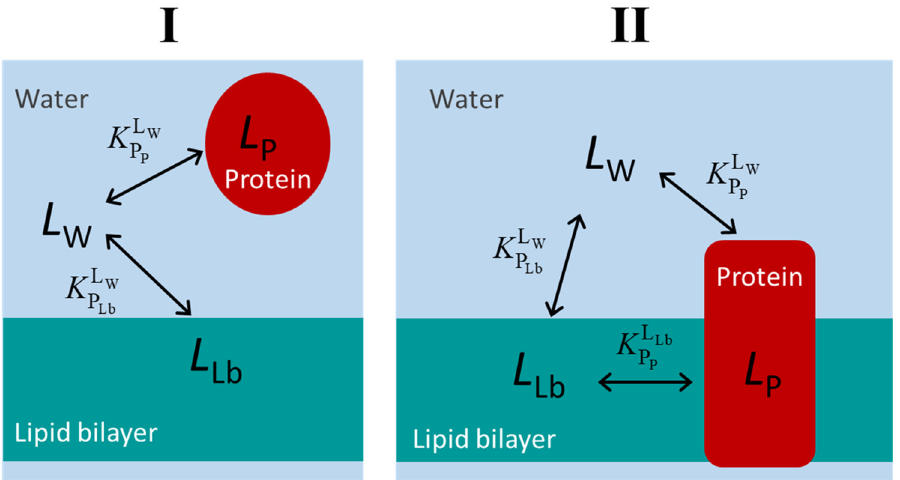
Figure 1. Kinetic schemes for the equilibrium distribution of the ligand between the aqueous medium, a protein soluble in the aqueous medium (case ( I )) or in the lipid membrane (case ( II )), and the membrane lipid bilayer. The association of the ligands to the protein is considered to occur to a single and well-defined binding site (saturable binding), while a partition (non-saturable) is considered for the association with the lipid bilayer.